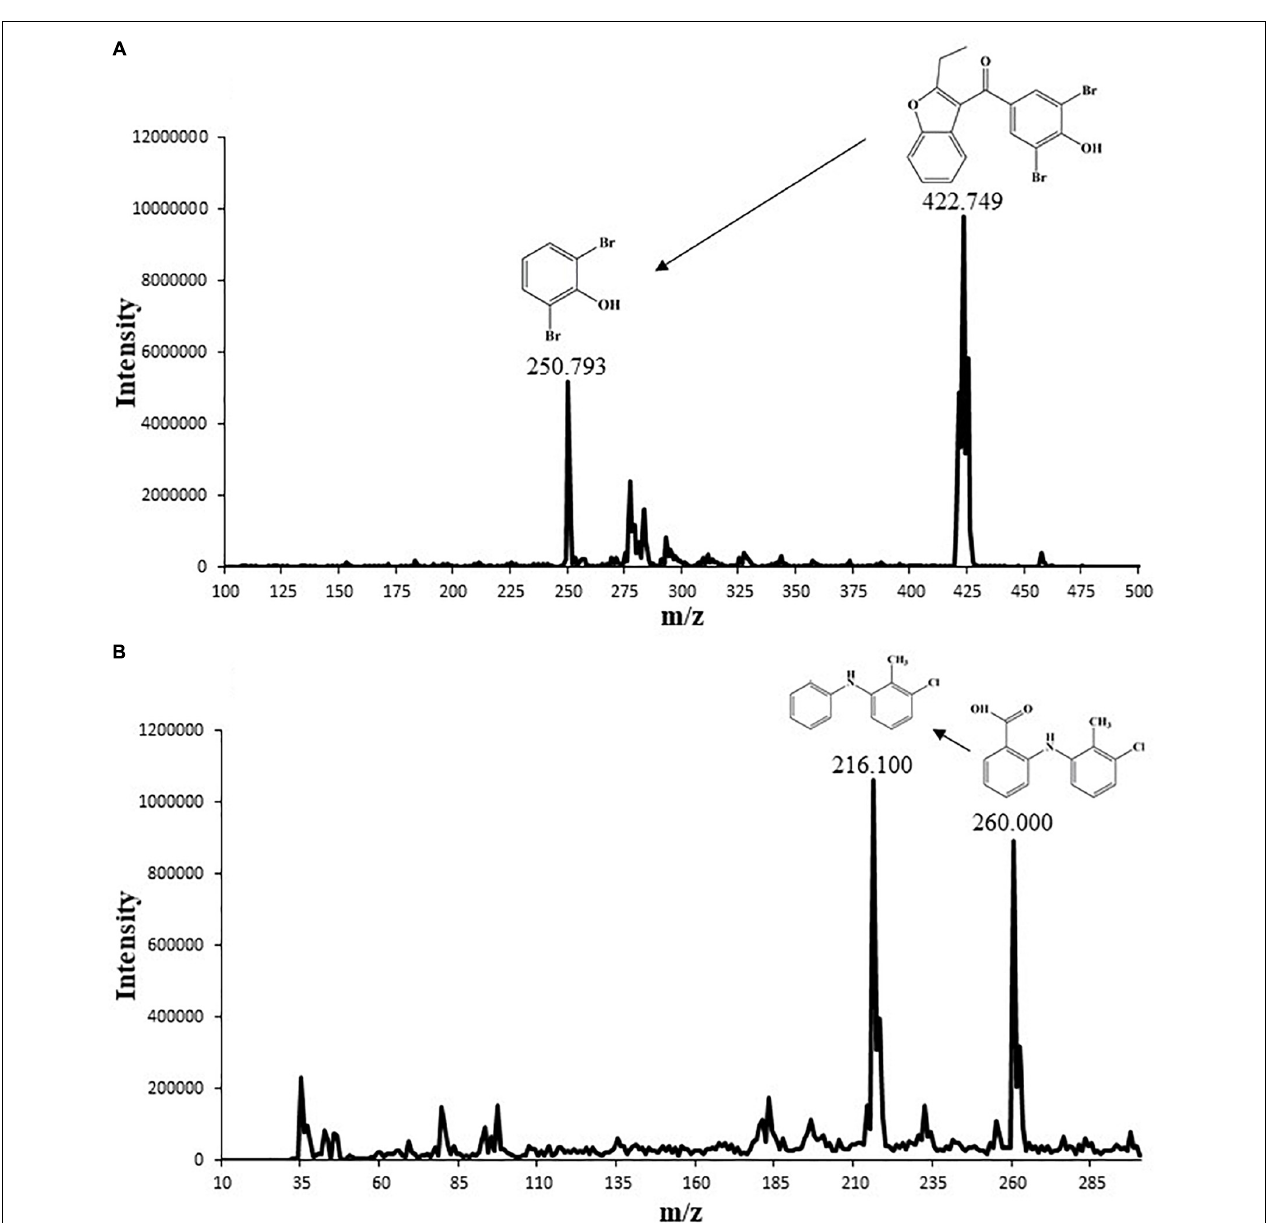
FIGURE 1 | Mass spectrum chromatogram showing the molecular size of (A) benzbromarone (peak 422.749) and (B) tolfenamic acid (peak 260.000) along with their chemical structure and potential degradation fragment.